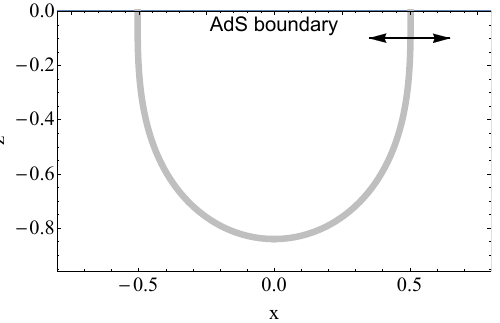
Figure 1 . The setup: a string is hanging from the boundary of AdS 3 . The configuration is initially static on the Poincaré patch. Then, a propagating wave is created by moving one of the endpoints as shown by the arrows. After the quench, the endpoints are fixed